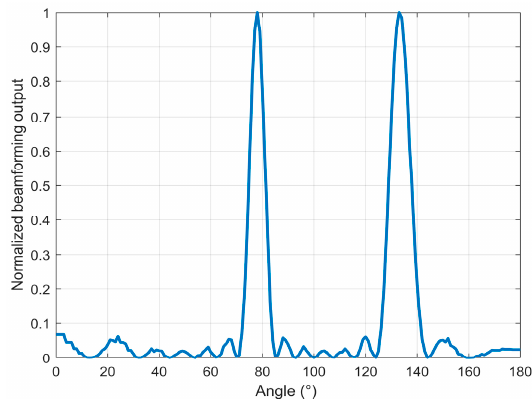
Figure 7. Simulation result of beamforming output ( d / λ = 1.37, main lobe of 78 ◦ and grazing lobe of 133 ◦).